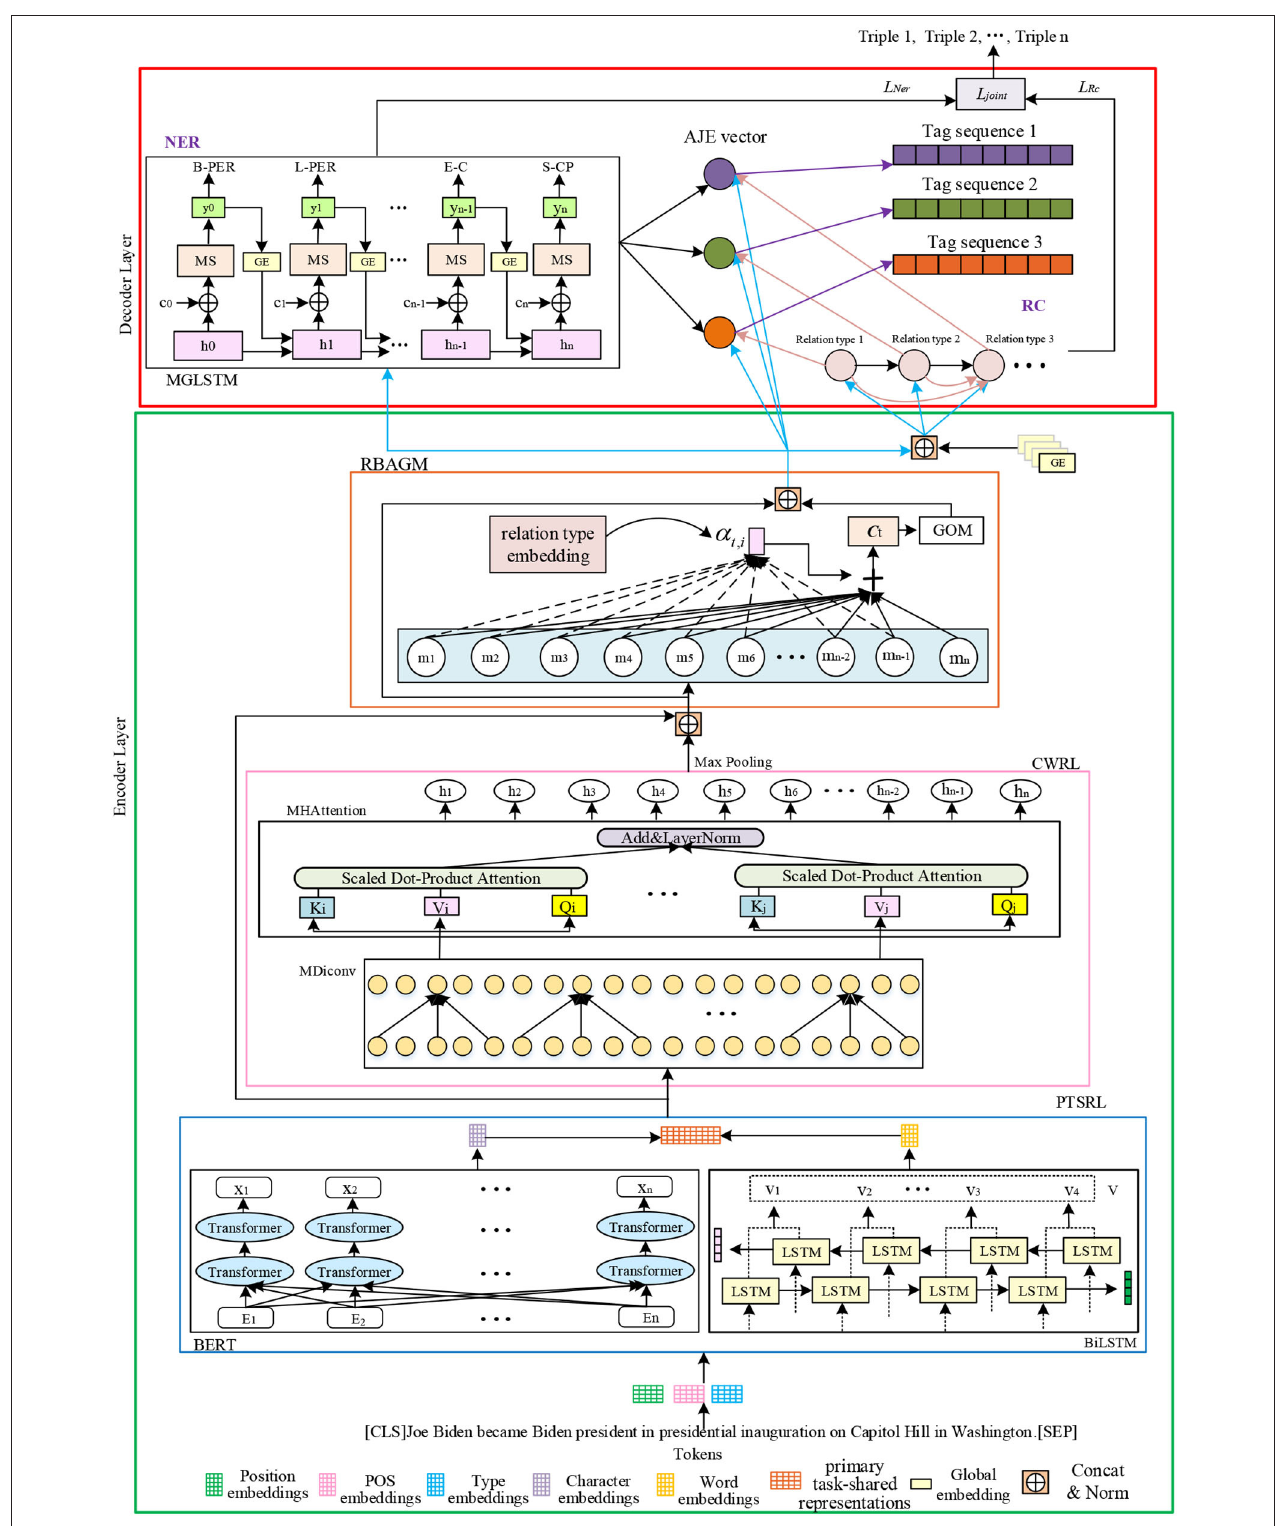
FIGURE 1 | The structure of ROMGCJE. The tokens of sentences are first represented as distributed word representations, which are then fed to the encoder layer containing PTSRL, CWRL, and RBAGM to capture rich contextual information and build long range dependency. Next, MGLSTM and MRC in the decoder layer are applied to perform decoding for NER and RC tasks, respectively. Finally, the MRT mechanism is applied to train ROMGCJE to extract the final relation triples.